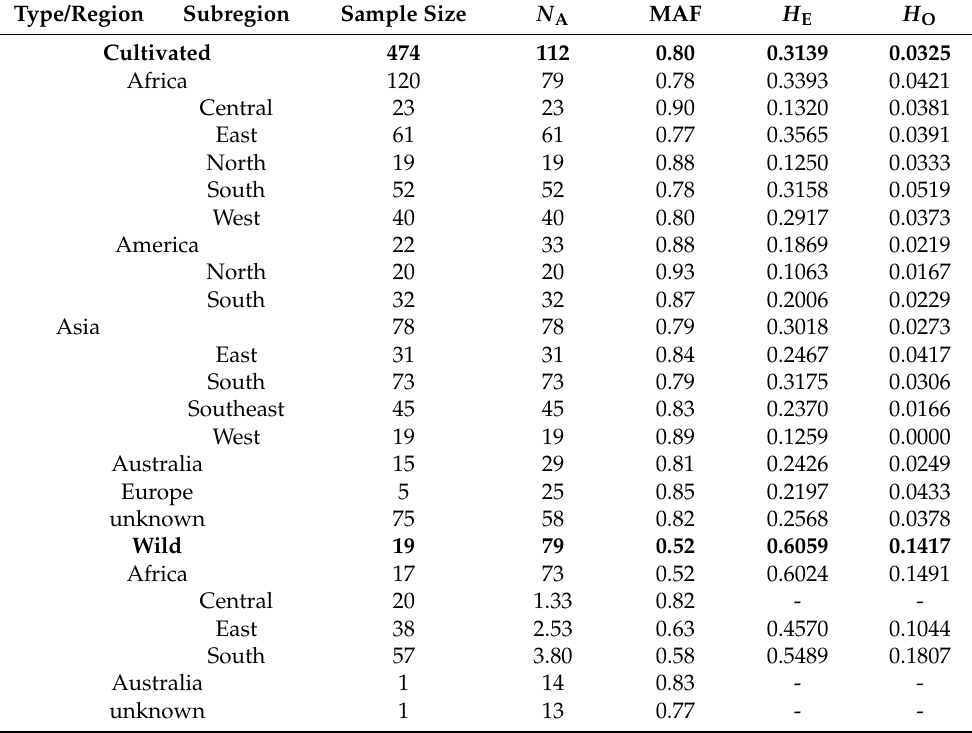
Table 3. Number of alleles per locus (N A ), major allele frequency (MAF), gene diversity ( H E ) and observed heterozygozity ( H O ) detected in 493 lablab accessions using 15 nuclear SSR markers.